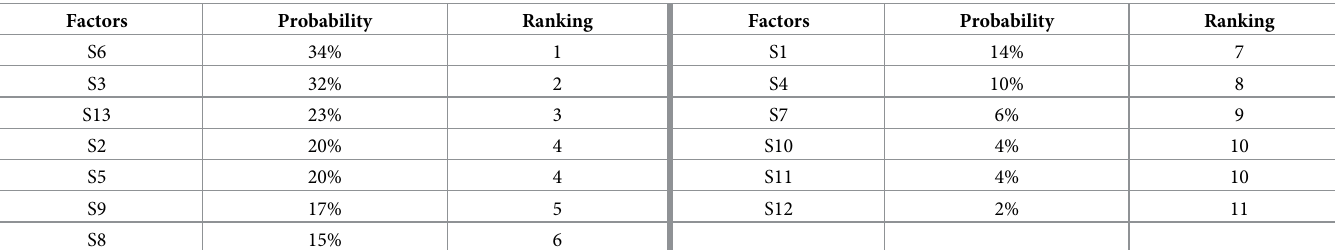
Table 11. Ranking of occurrence probability of influencing factors.